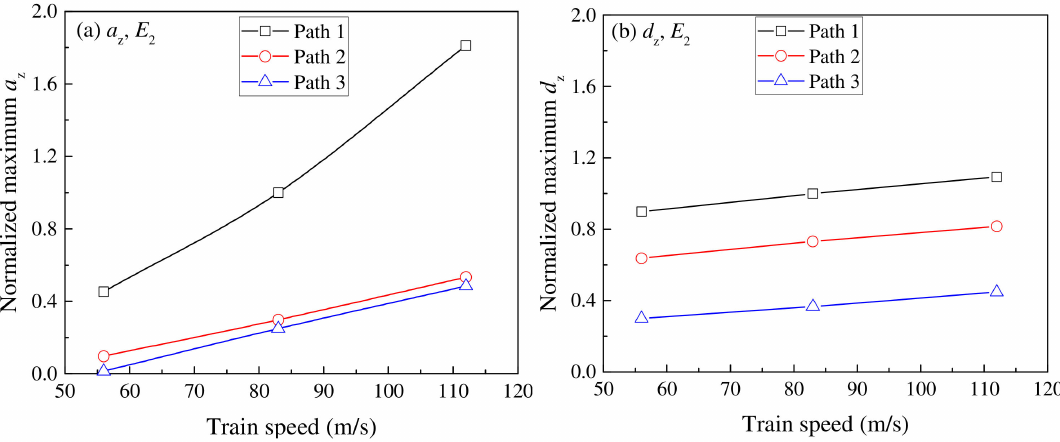
Figure 12. Variations of normalized maximum a z and d z with train speed in different paths: ( a ) a z ; ( b ) d z